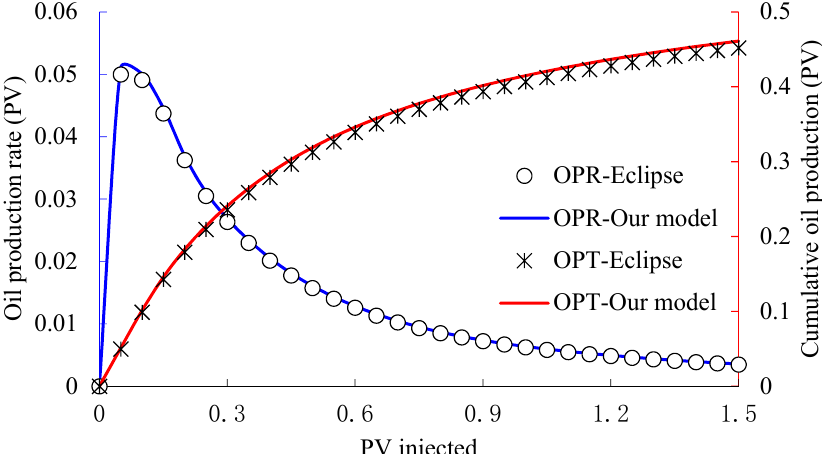
Figure 8. Water saturation profiles at different injection pore volume multiples.